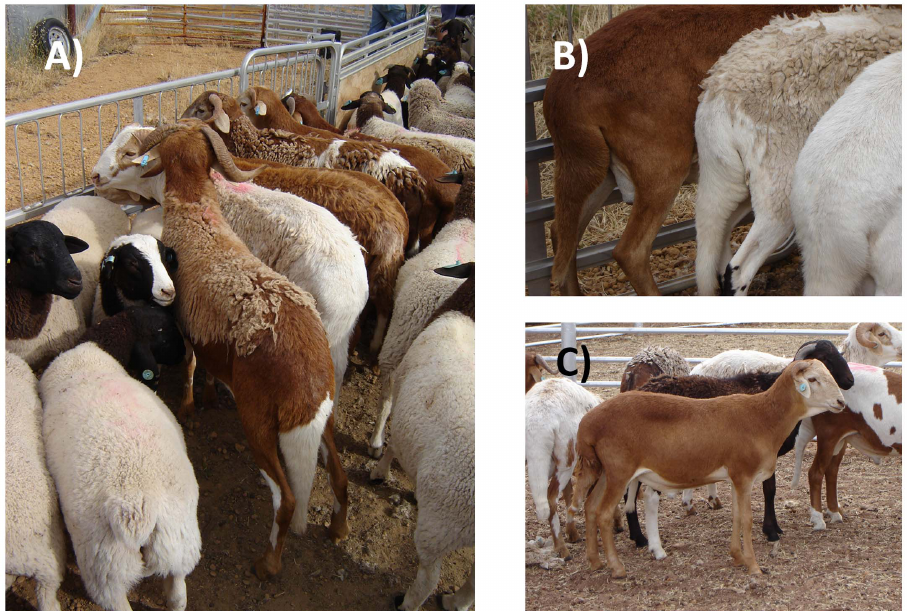
Figure 1. Damara fat tailed sheep. A) Damara, Dorper and Australian Merino rams at the initial stages of the feeding trial. Notice the characteristic hanging fat tail of the ram up front. B) Several aspects of the fat tail in several of the Damara rams used in this trial. C) In the first plane, brown Damara ram.